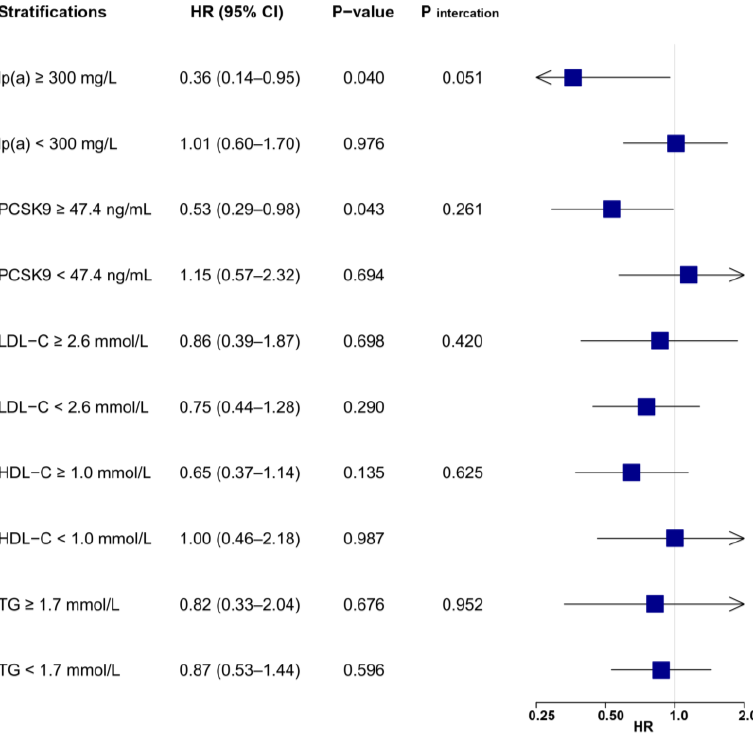
Figure 6. Associations between LL-37 and the risk of all-cause death according to lipid profile values. Multivariable Cox regression was adjusted for variables with p < 0.1 in univariable analysis (see Supplementary Table S3), including age, gender, body mass index, hypertension, diabetes, previous myocardial infarction, heart rate, systolic BP, diastolic BP, ejection fraction, leucocytes, hemoglobin, creatinine, glucose, hemoglobin A1c, high-sensitivity C-reactive protein, cardiac troponin I, N-terminal prohormone of brain natriuretic peptide, LDL-C, TG, culprit lesion, multivessel diseases, successful revascularization, aspirin, P2Y12 inhibitor, and statin. BP = blood pressure; HDL-C = high- density lipoprotein cholesterol; LDL-C = low-density lipoprotein cholesterol; lp(a) = lipoprotein(a); PCSK9 = proprotein convertase subtilisin/kexin type 9; TG = triglyceride.